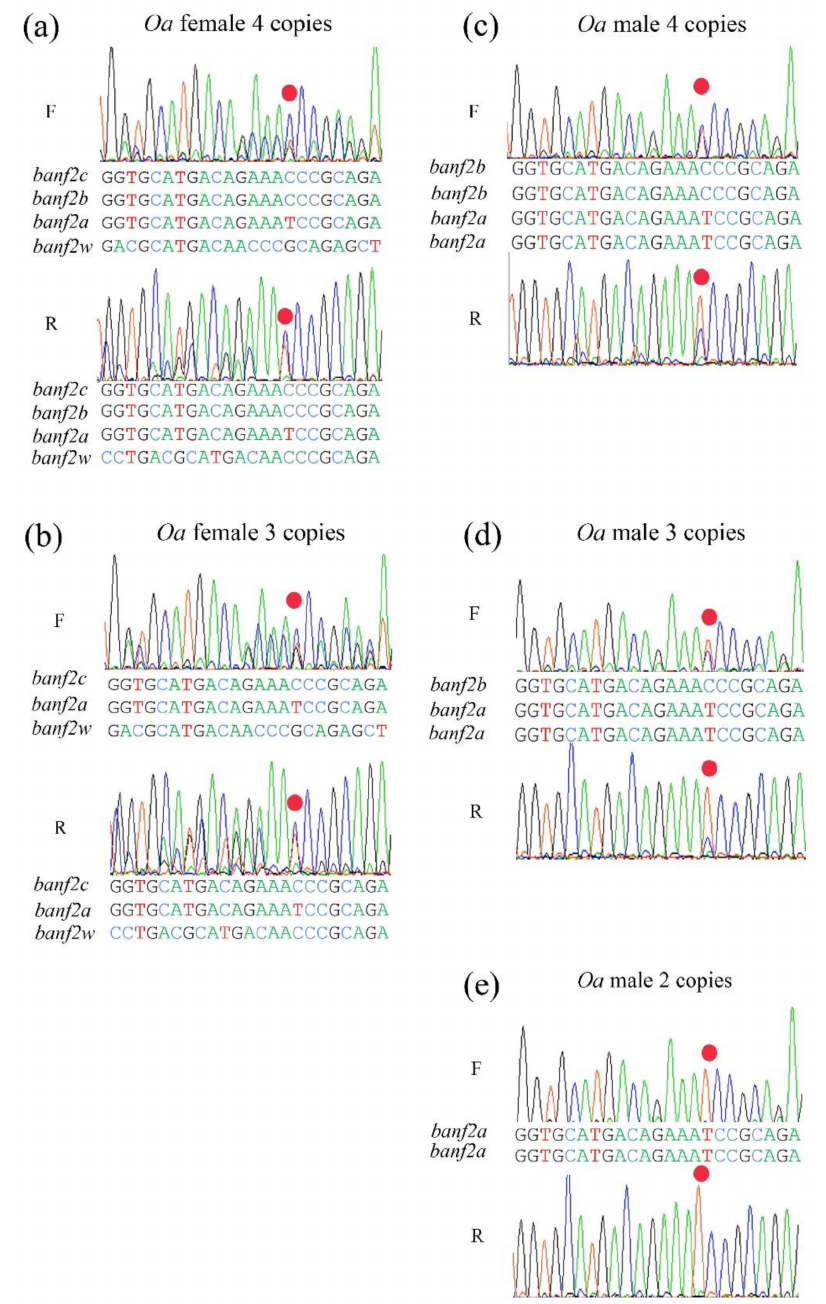
Figure 4. Polymorphism in Oreochromis aureus ( Oa ) hybrid stock in Sanger chromatograms of the third exon of banf2 genes. Chromatograms a-e correspond to models a-e in Figure 4, respectively. Copy proportion analysis was based on both forward (F) and reverse (R) sequencing orientations. The nucleotide sequences below the chromatogram traces were interpreted using Tide software, which, by trace decomposition analysis, estimated that the ratio of banf2w was 25% of the signal intensity in some Oa females ( a ), and was 33% of this signal in others ( b ), suggesting four and three copies, respectively. The red dots mark an informative position disclosing multiple copies with either C, T or G peaks. For males, this informative site suggested a 2–4-copy model ( c – e ). The presence of banf2a and 2b or 2c was reflected in the observed peak-height ratio between T and C. C was not observed in a homozygous state, and thus it represented a gene duplication that was in tandem with the copy carrying